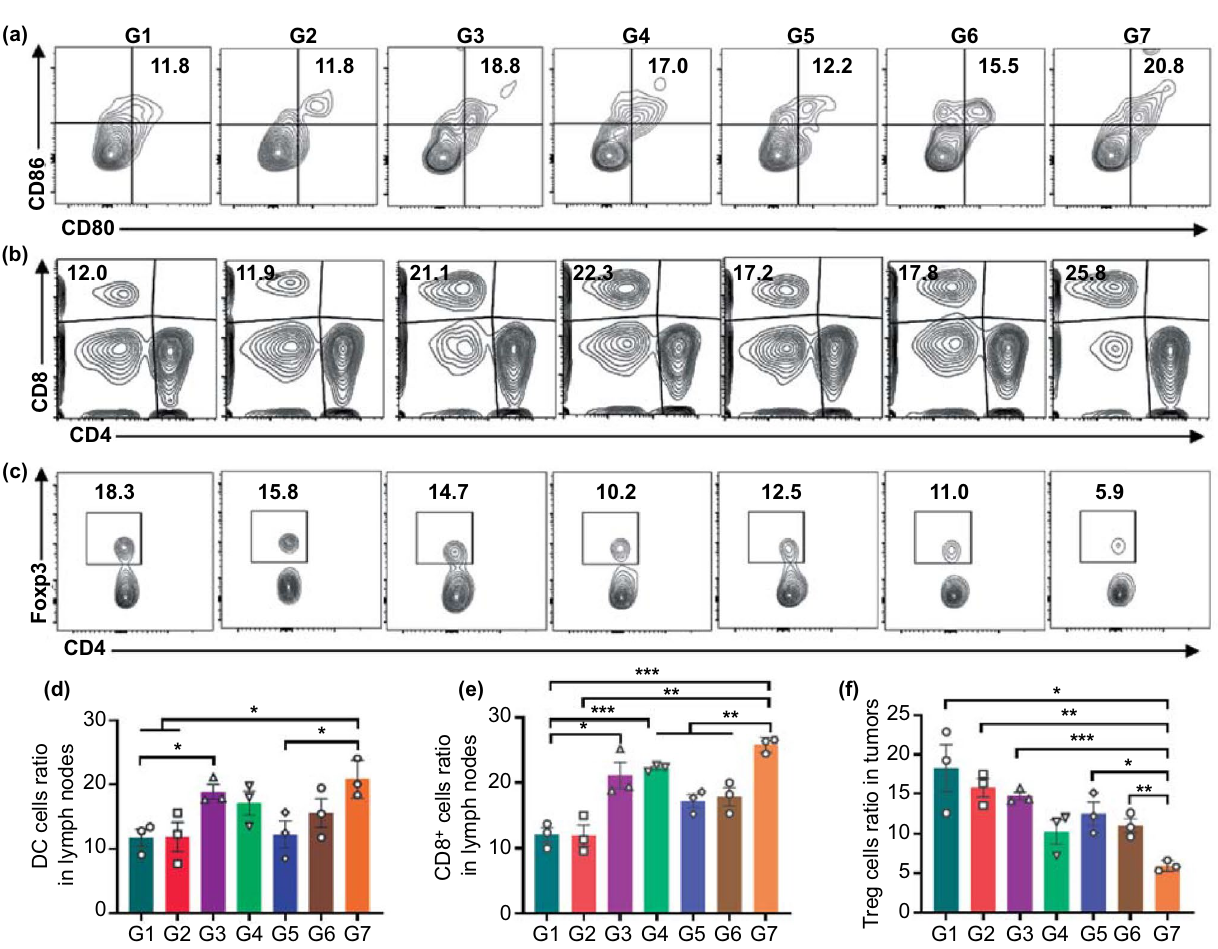
Fig. 6 Immune responses on tumor resected mice induced by DLG matrix-based treatment strategy. a‑c Representative flow cytometric analysis of mature DCs (gated on CD11c + DC cells), tumor-infiltrating of CTLs (gated on CD3 + T cells), and CD4 + Foxp3 + Tregs (gated on CD3 + CD4 + cells) from different groups of 4T1 tumor resection mice examined on Day 8 after different treatments. d‑f The relative quantification of mature DCs, CD8 + T cells, and Tregs on Day 8 after different treatments. Data are shown mean ± SEM ( n = 3). The statistical comparison between groups was performed following the student’s t test (two-tailed). * p < 0.05, ** p < 0.01 and *** p <